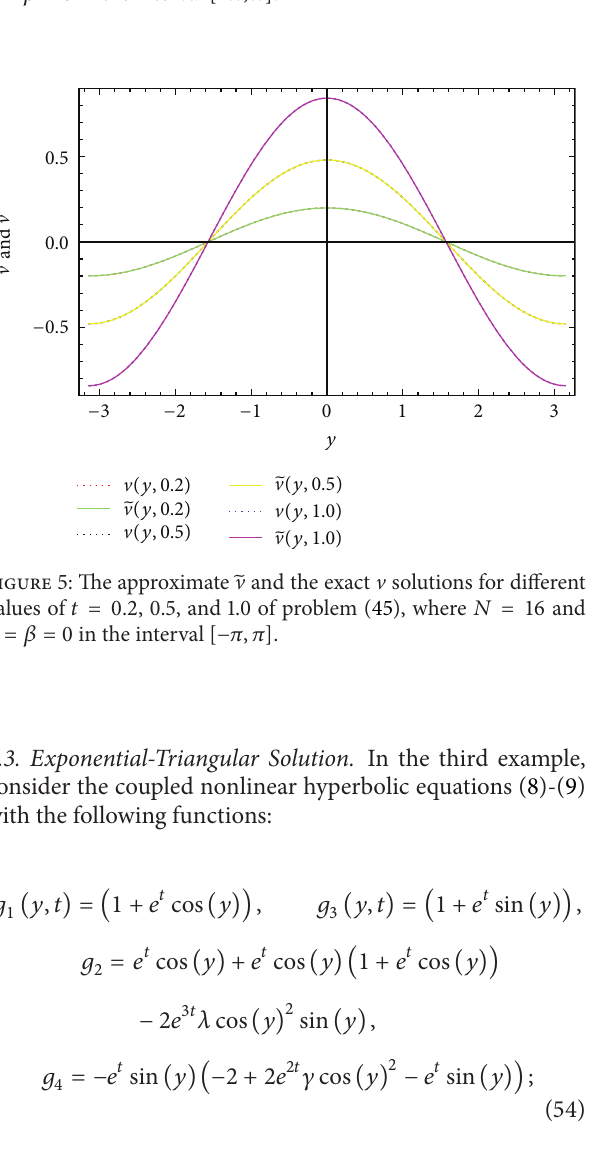
Figure 4: The approximate ̃𝑢 and the exact 𝑢 solutions for different values of 𝑦 = 0.1 , 0.5, and 1.0 of problem (45), where 𝑁 = 16 and 𝛼 = 𝛽 = 0 in the interval [−𝜋,𝜋] .